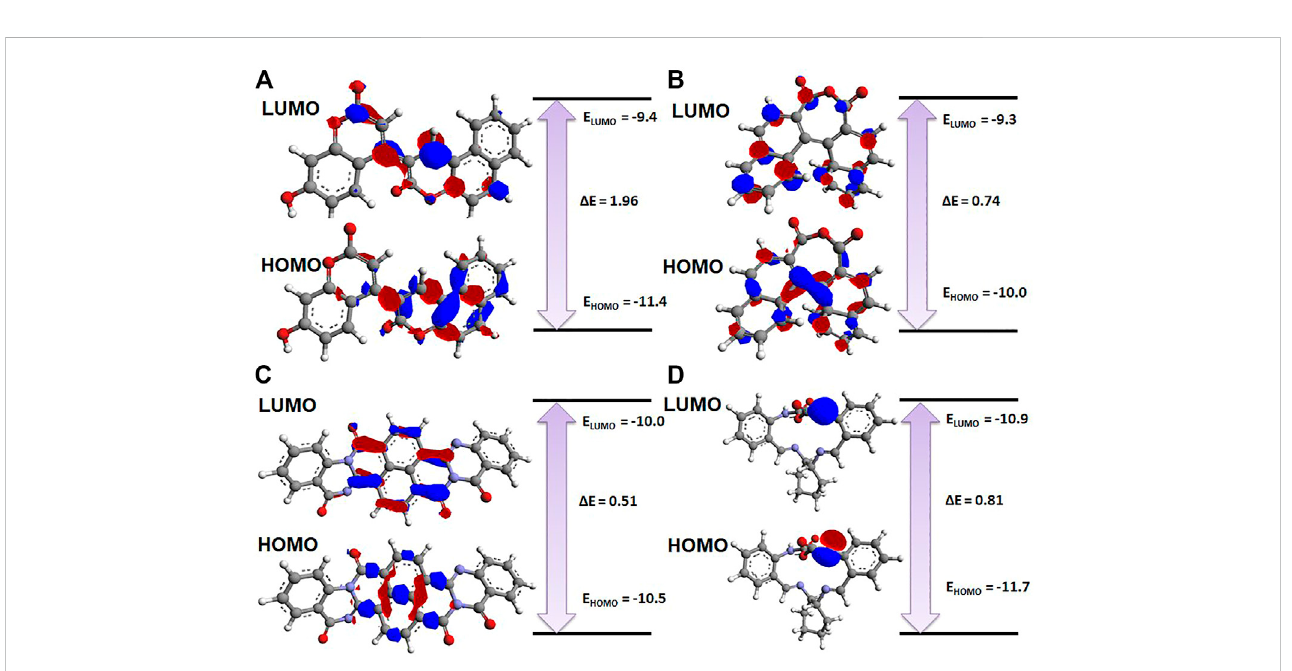
FIGURE 5 Charge distribution of HOMO and LUMO with their energy bands. (A) ZINC2123081, (B) ZINC3843365, (C) ZINC5220992, and (D) ZINC68569602. The red and blue colors represent the negative and positive charge, respectively.